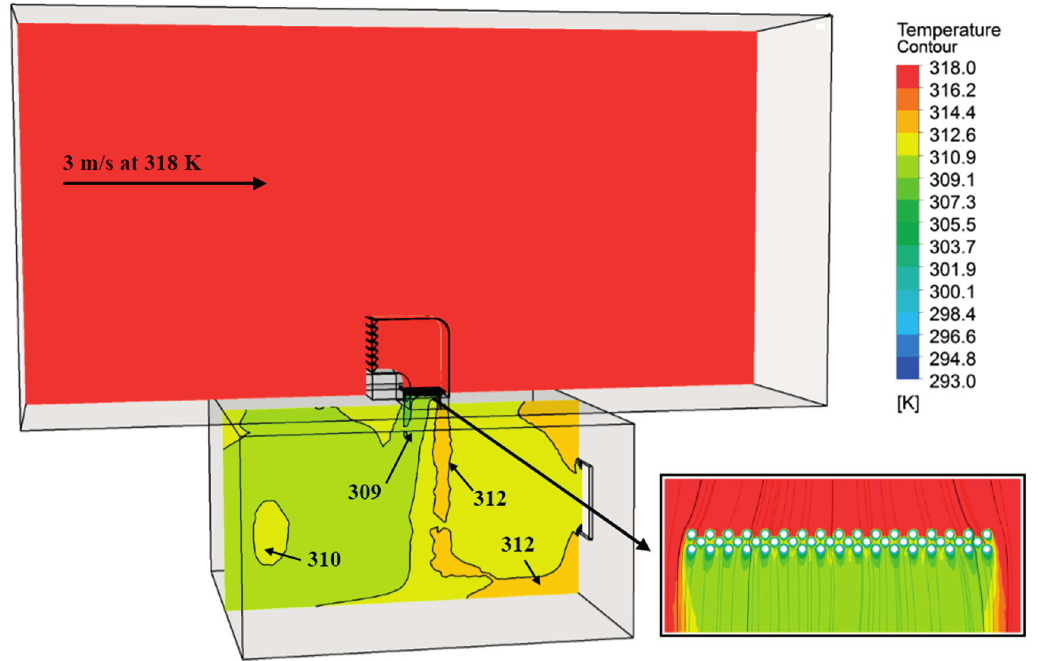
Figure 16. Cross-sectional plot of the temperature contour.